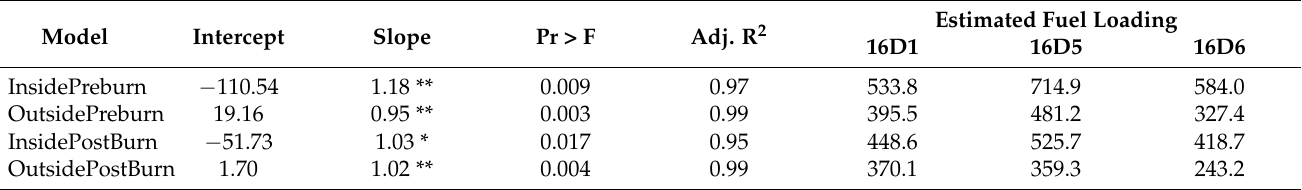
Table 4. Summary of simple linear regression models used to estimate missing ground truth shrub fuel loading (g/m 3 ) for small prescribed burns at Ft. Jackson, SC, burned in April 2018. “*” and “**” indicate that the estimated coefficient (intercept, slope) was significant at the 0.05 and 0.01 probability levels, respectively.